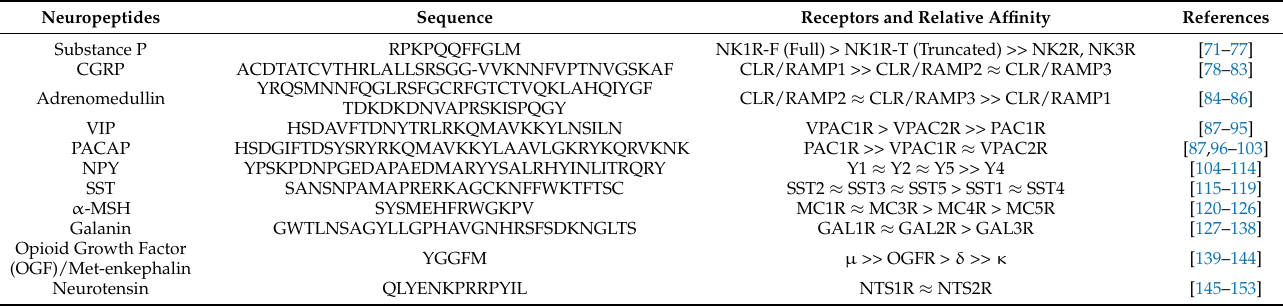
Table 1. Neuropeptide structures and their